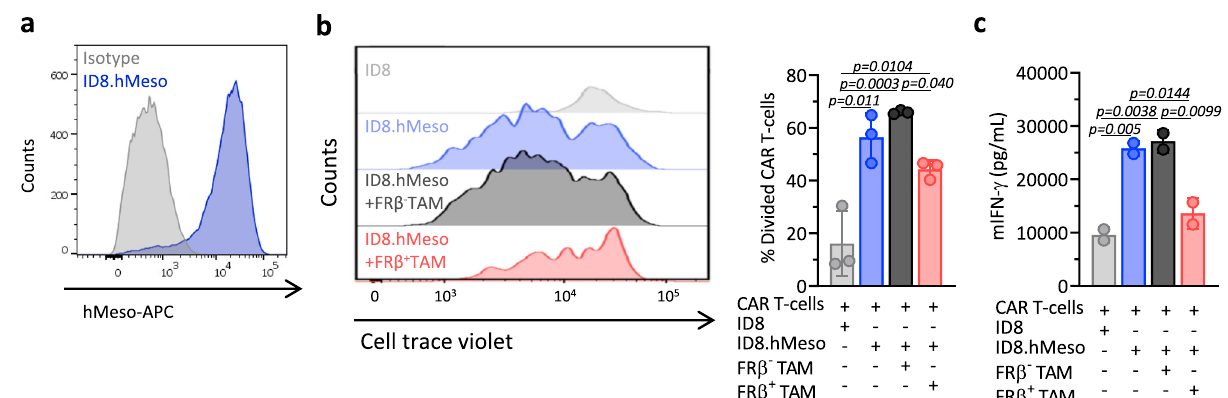
Fig. 3 FR β + TAMs inhibit antigen-speci fi c T cell function. a Expression of human mesothelin (hMeso) in engineered ID8.hMeso cells as detected by fl ow cytometry. Representative histogram (gray – isotype, blue — hMeso) is shown. hMeso-speci fi c mouse CAR-T cells labeled with cell trace violet (a fl uorescent dye that is diluted with cell proliferation) were cocultured with ID8 or ID8.hMeso target cells in the presence of fl ow-sorted FR β − or FR β + TAMs for 72 h. b Representative histograms looking at cell trace violet staining on CAR + T cells (gated on live, CD3 + GFP + , left panel) as well as mean percentage of divided cells ± SD of triplicates (right panel) are shown. c mIFN- γ levels in 72 h supernatants as detected by ELISA. Mean of technical duplicates ± SD is shown. b , c Representative data from two independent experiments. P values by a one-way ANOVA with Tukey ’ s multiple comparison test are indicated. Source data are provided in the Source Data fi le.